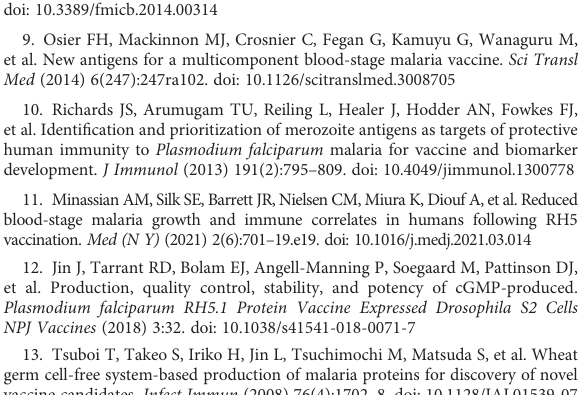
fi mmu.2022.1002430/full#supplementary-material SUPPLEMENTARY FIGURE 1 Correlation between mean anti-PfRipr5 ELISA titers and mean GIA activities (n = 6 rabbits/group). PfRipr5 antigen only (black fi lled circle), Adjuvant only (open squares), 50 m g dose of PfRipr5 ( fi lled triangles), 200 m g dose of PfRipr5 ( fi lled diamonds), formulation with Alhydrogel ® (Alum; blue), GLA-SE (GLA; magenta), and CAF ® 01 (CAF; purple). Pearson ’ s correlation coef fi cient was calculated as r = 0.9438